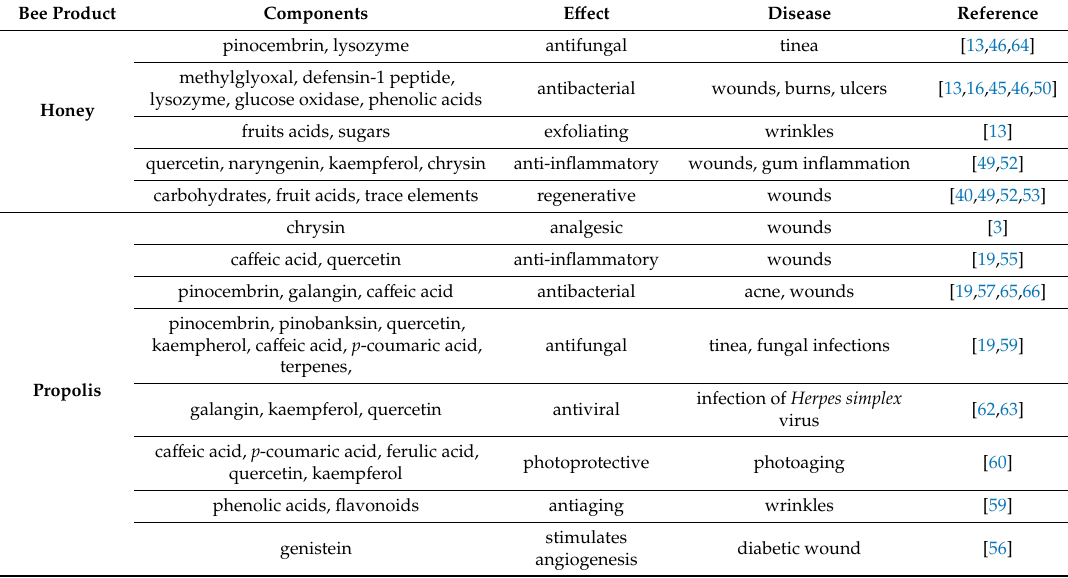
Table 2. The summary of the skin diseases where the therapeutic application of bee products has been